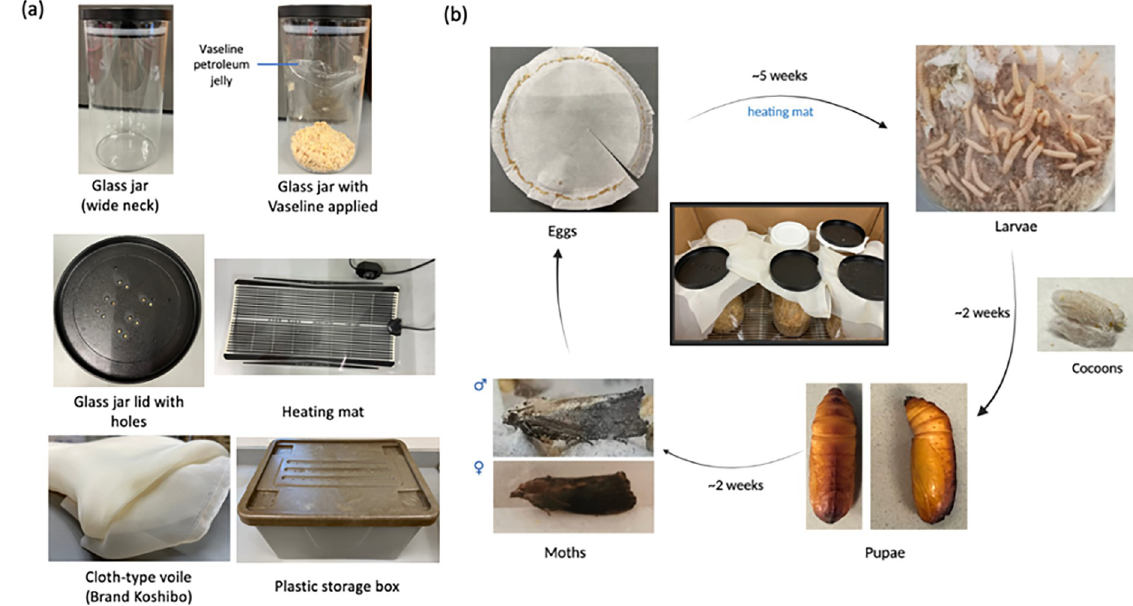
Fig 2. Rearing and maintenance of G . mellonella in the science research laboratory. (a) Housing equipment for G . mellonella . (b) The lifecycle of G . mellonella reared and maintained in our research laboratory. The larval stage of G . mellonella (eggs to last-instar stage larvae) was maintained at a temperature-controlled condition with a heating